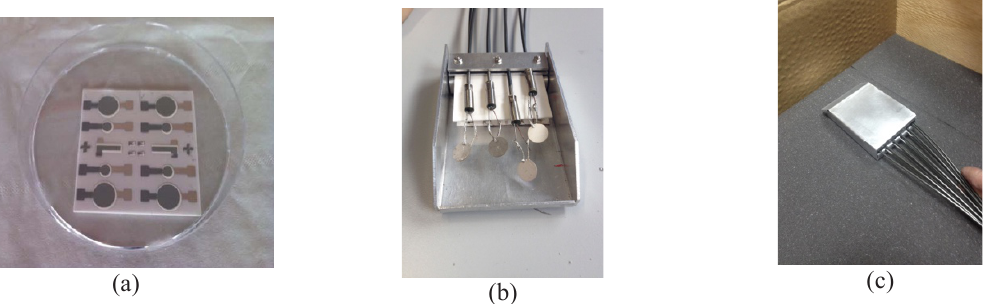
Fig. 5 : pictures detailing the different piezoelectric elements inserted in the specimen holder. (a) piezoelectric thick films on alumina substrate, (b) all piezoelectric samples and associated cables before closing the cavity, (c) sealed